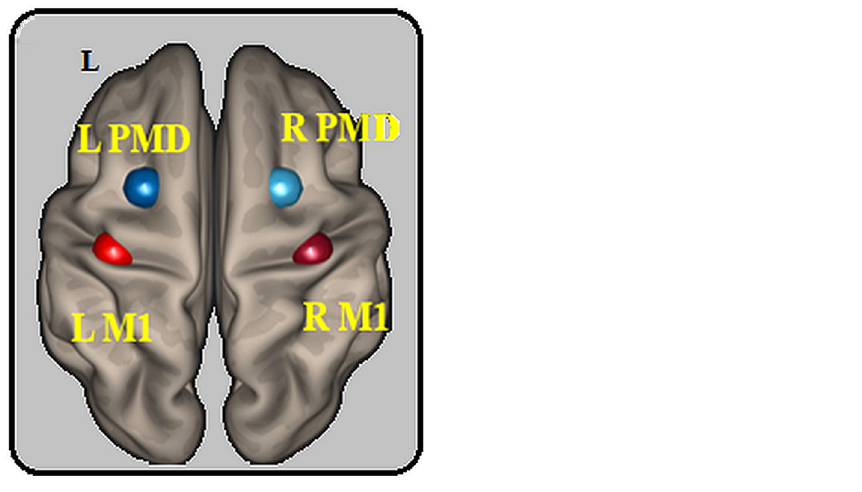
Figure 7. Location of the regions of interest. Location of the 4 ROIs based on the meta-analysis from Hardwick and collaborators 38 . Each ROI was defined as a sphere with a radius of 10 mm around the reported peak coordinates for each region. These were: left M1 (x = − 38, y = − 24, z = 56), right M1 (x = 38, y = − 24, z = 56), left PMd (x = − 26, y = 2, z = 60), right PMd (x = 26, y = 2, z = 60). L: left, M1: primary motor area, PMd: dorsal premotor cortex, R: right, ROI: region of interest